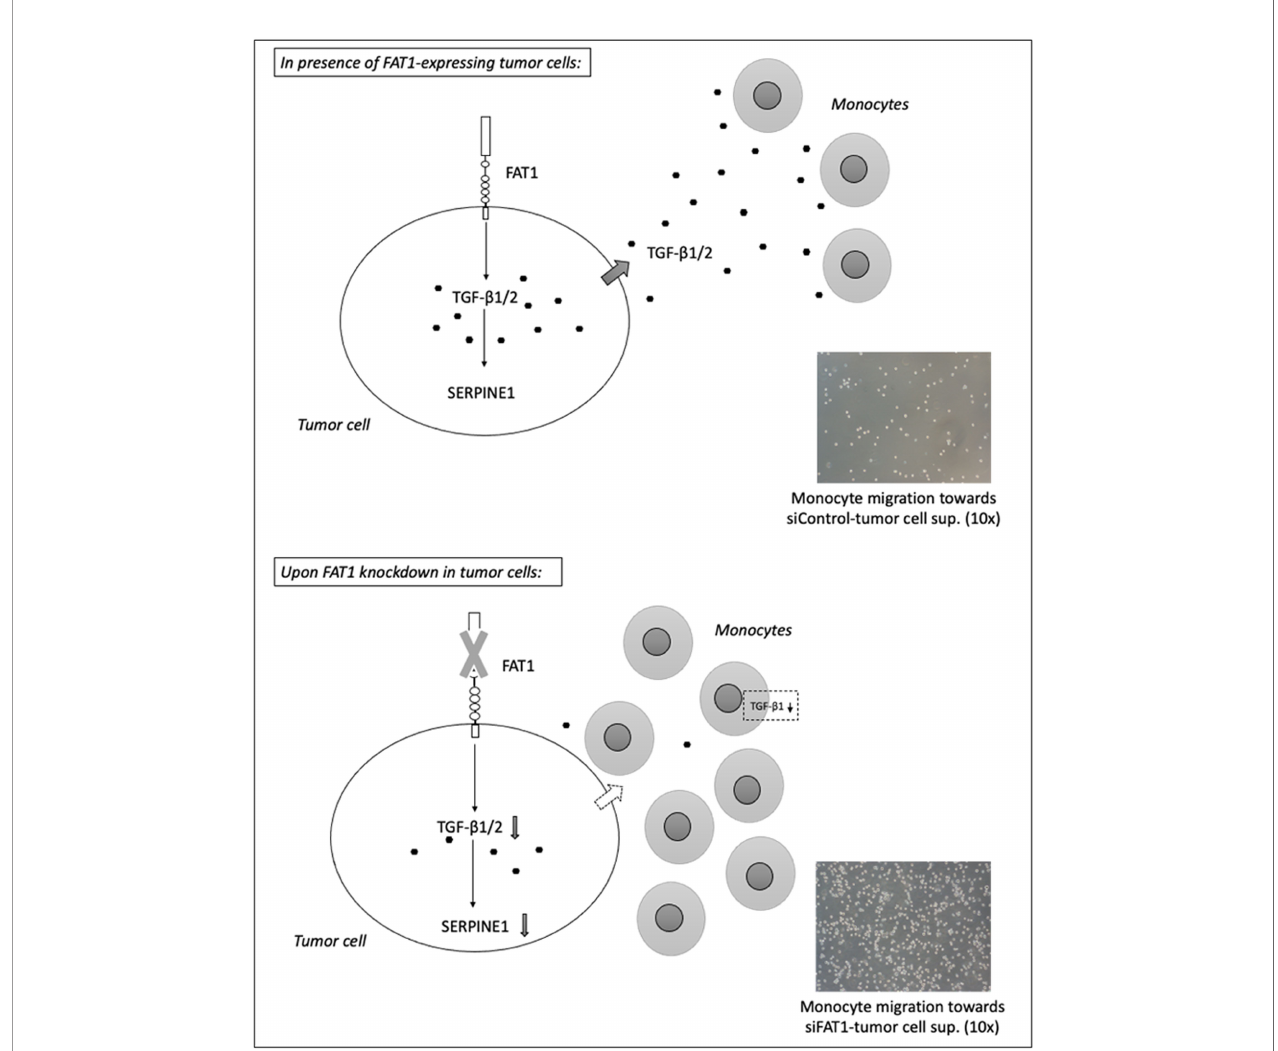
FIGURE 4 | Summary diagram depicts the potential immunosuppressive mechanism mediated by FAT1-expressing tumor cells in a heterogeneous solid tumor microenvironment ( upper panel ). As per TIMER2.0 analysis, FAT1 expression correlates inversely with the in fi ltration of tumor-inhibiting immune cells in TCGA cancers. The molecular and phenotypic changes in the tumor microenvironment following FAT1 knockdown in tumor cells have been shown ( lower panel ). As per THP-1 transmigration experiments, decreased TGF- b 1 secretion from FAT1-depleted tumor cells may be responsible for increased chemotactic activity of monocytes toward conditioned media of FAT1-depleted tumor cells. When cultured in such conditioned medium, THP-1 monocytes also synthesize reduced TGF- b 1, further revealing the contribution of FAT1 in inducing an immunosuppressive